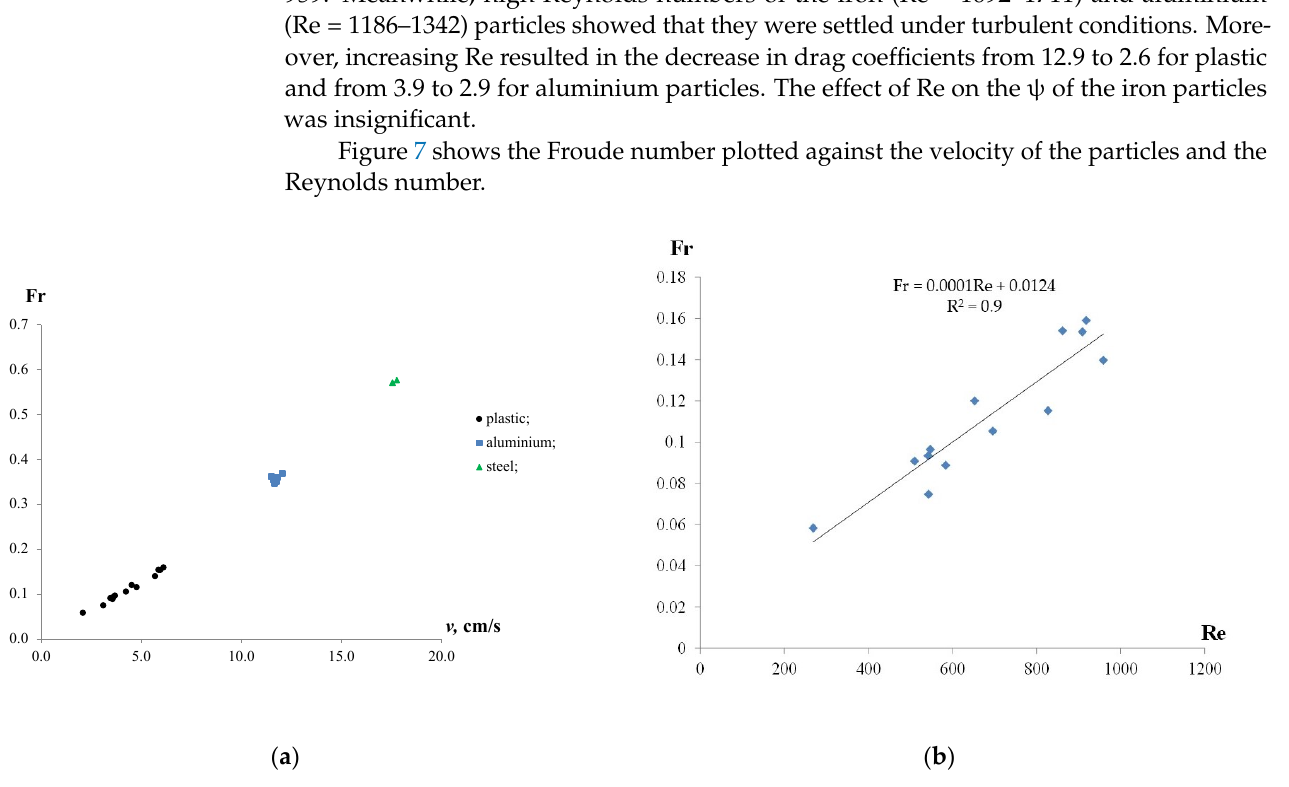
Figure 6. Drag coefficient for plastic, iron and aluminium particles with various d e ( a ) and Reynolds numbers ( b ).